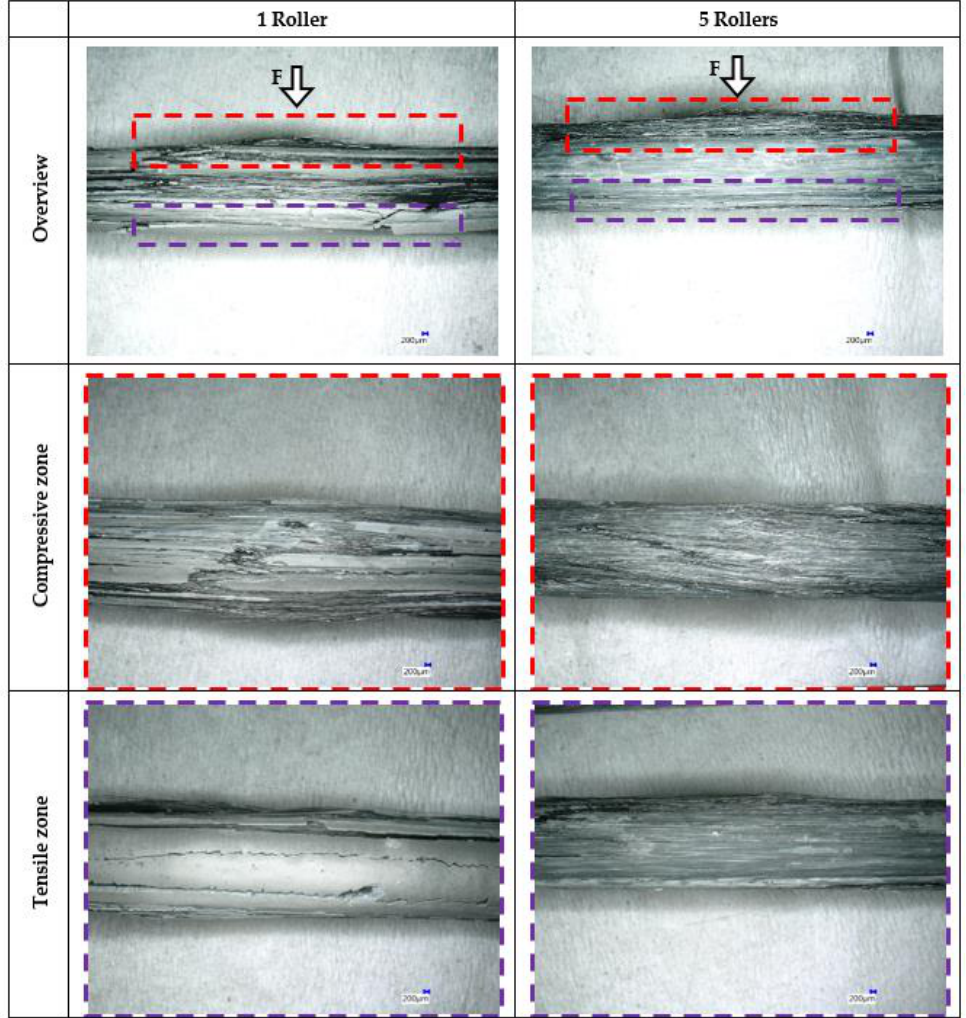
Figure 7. Optical micrographs of the typical failure mode of MCF produced with one roller and five rollers, as observed after bending tests. Red and purple boxes focus on the compressive and tensions zone, respectively. White arrows indicate the applied load direction during bending tests.